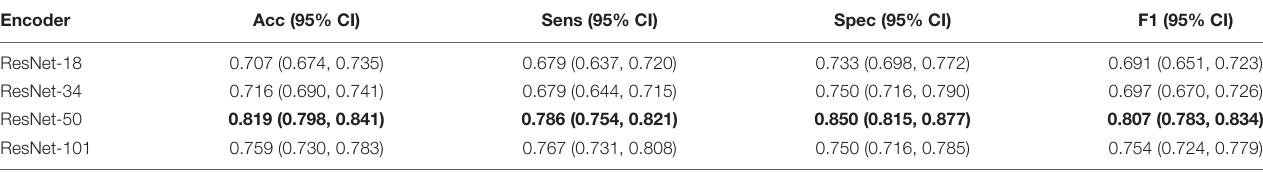
model parameters and obtain general imaging features.